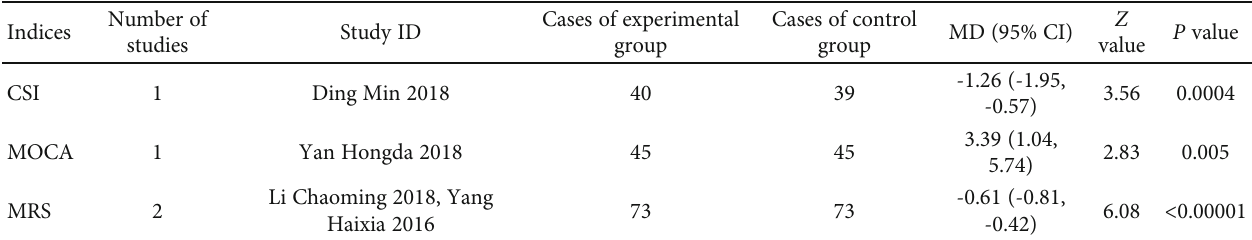
Table 8: OTTCM combined with routine treatment vs. routine treatment on the observation index.